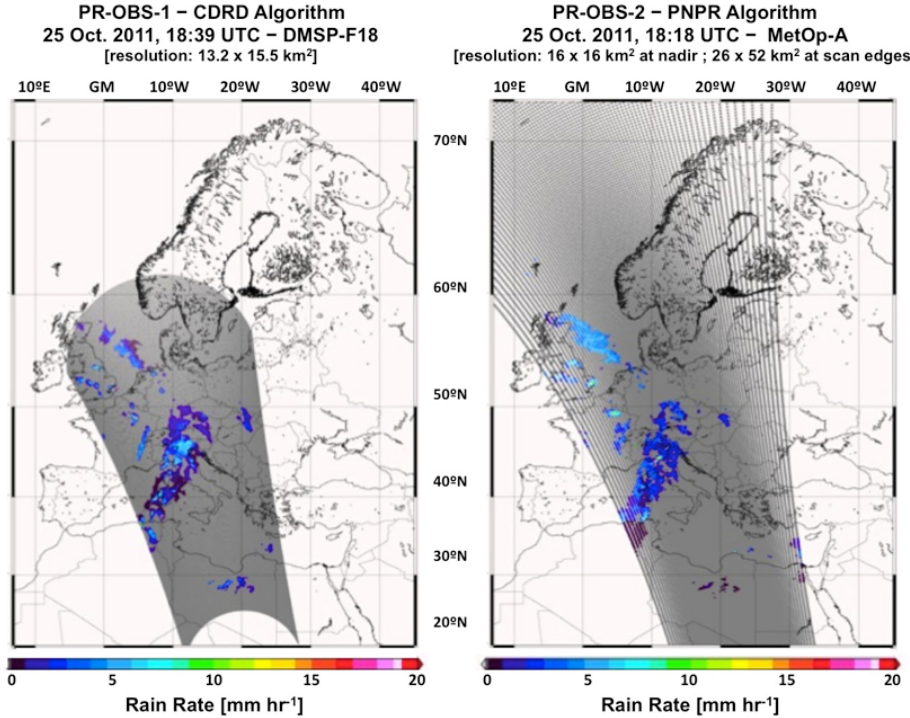
Fig. 2. Example of PR-OBS-1 and PR-OBS-2 precipitation rate retrievals on 25 October 2011. The left panel shows H01 product relative to a SSMIS (DMSP F18) overpass at 18:39UTC, while the right panel shows near-correlated H02 product relative to an AMSU-A + MHS (MetOp-A) overpass at